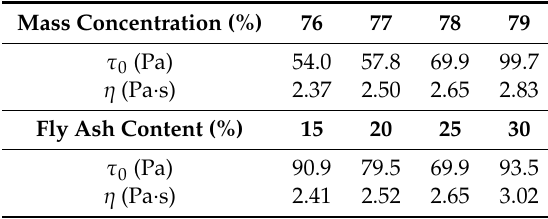
Table 3. Rheological parameter values of the